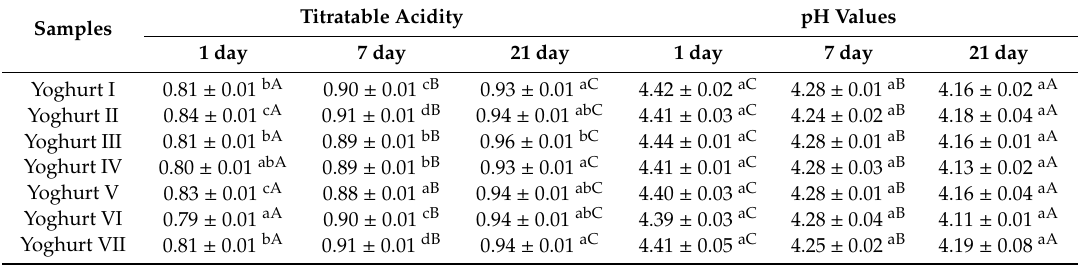
Table 1. Titratable acidity (lactic acid %) and pH values of Yoghurts I–VII during their storage at 4 ◦ C. Titratable Samples